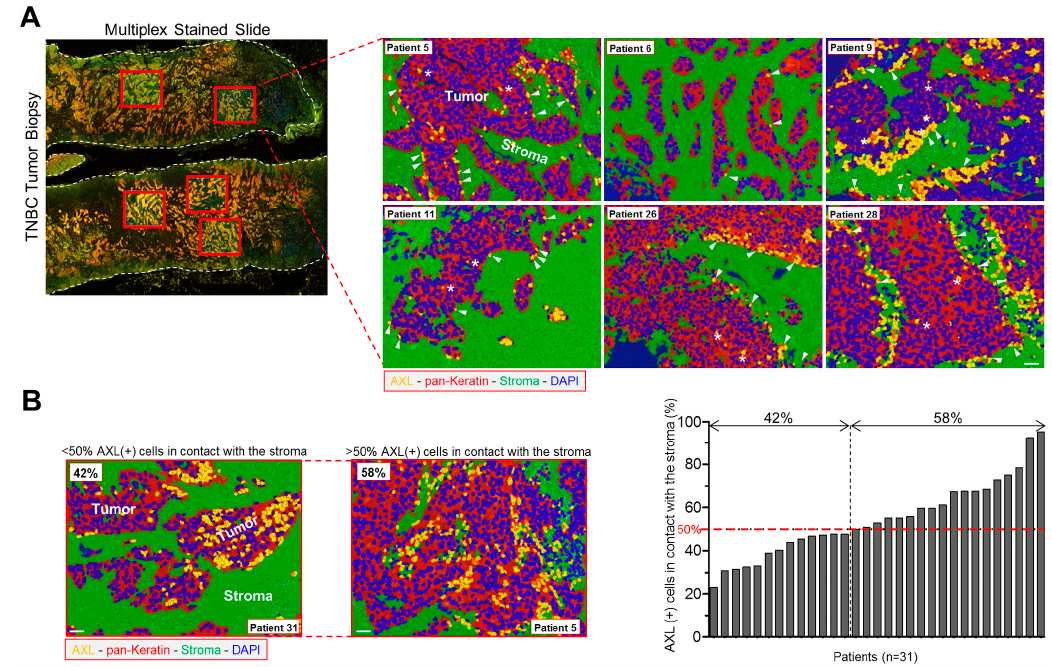
Figure 6. AXL expressing tumor cells are preferentially localized in contact with the stroma in untreated aggressive TNBC biopsies. ( A ) Left panel: image of a multiplex stained slide from a human TNBC sample with selected areas for analysis (red boxes). The white dashed lines delineate the tumor sample. Right panel: representative images obtained from six different TNBC patients showing AXL-positive cells at the contact with the stroma. Staining: AXL (yellow), pan-Keratin-AE1 / AE3 (red) and DAPI (blue). The area that was negative for cytokeratin was considered as stroma and stained in green. Arrowheads point to AXL-positive cells in contact with the stroma, stars point to AXL-positive cells that are not close to the stroma. ( B ) Left panel: representative images from two TNBC patients: AXL (yellow), pan-Keratin-AE1 / AE3 (red), DAPI (blue), stroma (green). Right panel: AXL-expressing (AXL ( + )) cells (%) in contact with the stroma in biopsies obtained from 31 TNBC patients. Patient’s number: number of regions counted / number of total cells counted; P1: 3 / 159; P2: 4 / 17; P3: 6 / 43; P4: 7 / 27; P5: 8 / 579; P6: 9 / 216; P7: 8 / 130; P8: 3 / 57; P9: 4 / 623; P10: 7 / 280; P11: 2 / 386; P12: 4 / 166; P13: 3 / 96; P14: 5 / 199; P15: 2 / 304; P16: 5 / 75; P17: 6 / 121; P18: 6 / 143; P19: 7 / 70; P20: 7 / 438; P21: 3 / 204; P22: 4 / 133; P23: 9 / 190;